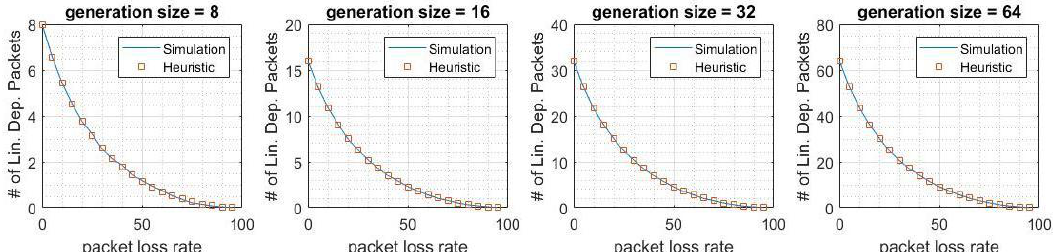
Figure 8. Number of linearly dependent packets in D in source coding.